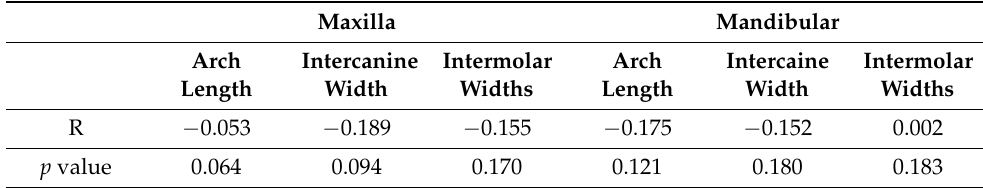
Table 2. Correlation between MTP and arch size parameters.